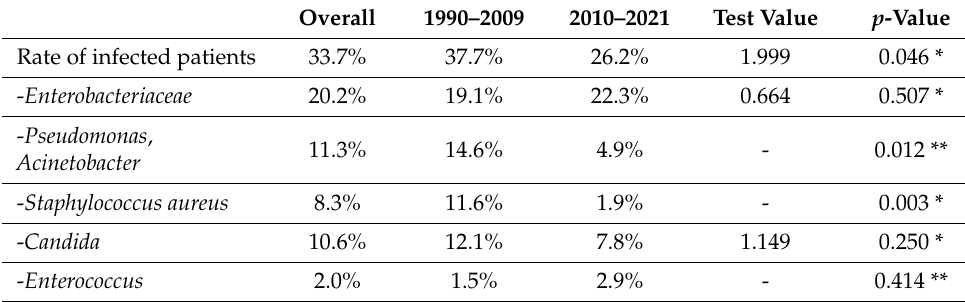
Table 2. Descriptive and inferential statistics of the analyzed